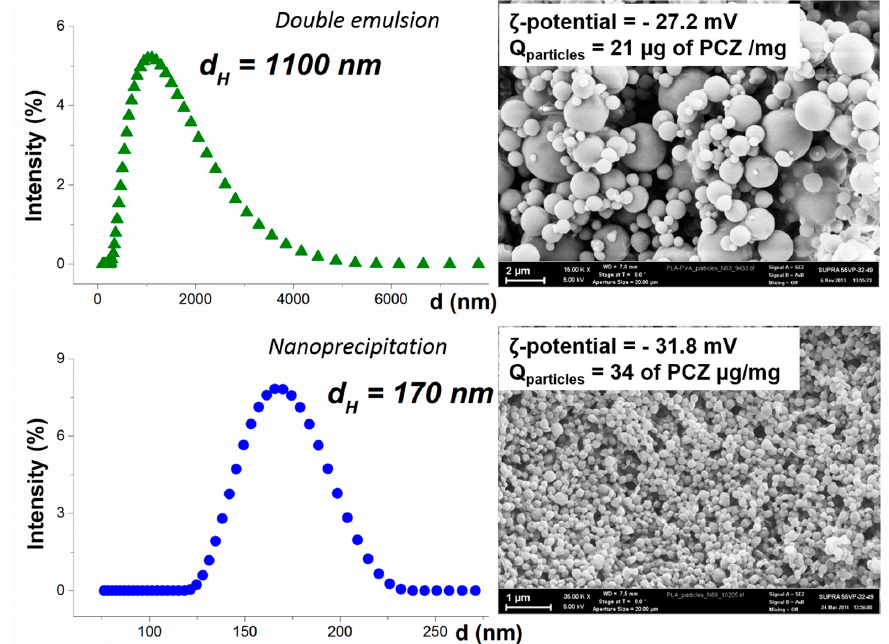
Figure 1. Characteristics of perchlozone loaded poly(lactic acid) (PLA) particles used for treatment of animals. Above: microparticles obtained by double emulsion method; below: nanoparticles obtained by nanoprecipitation.